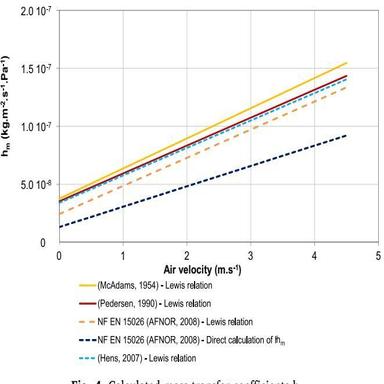
Sketch of the apparatus for measuring capillary absorption coefficient.